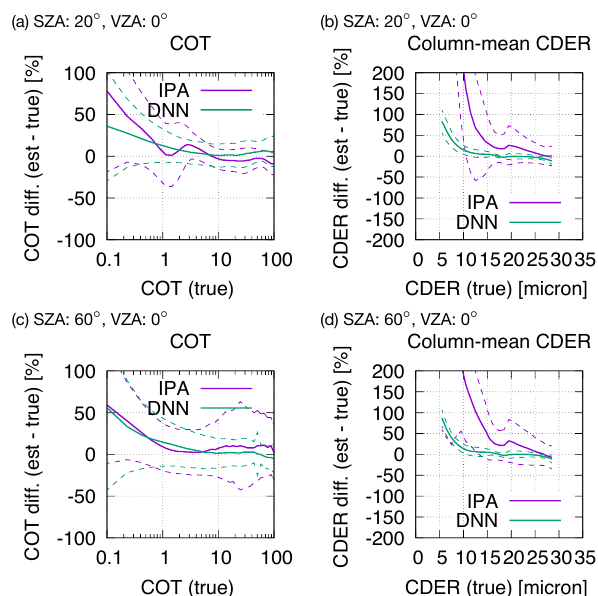
Figure 7. Comparison of retrieval errors of DNN-4w and IPA re- trieval for SZAs of (a, b) 20 ◦ and (c, d) 60 ◦ . The horizontal axes show the true values of either COT or column-mean CDER. The vertical axes show the relative error of the estimated cloud prop- erty. The solid and dashed lines denote mean errors and means ± standard deviations of error,